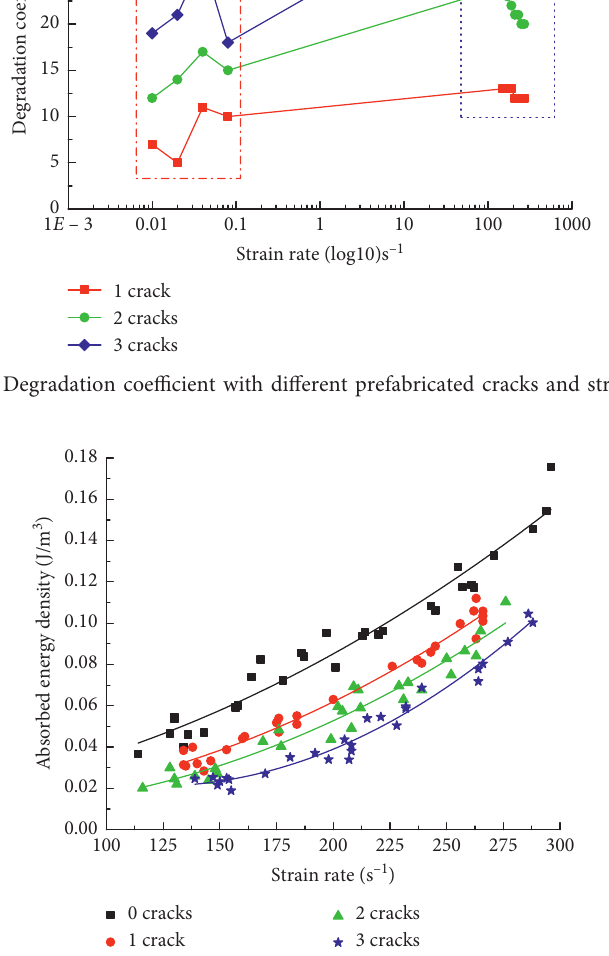
Figure 10: Variation in absorbed energy density of frozen silty soil with strain rates. Table 2: The values of fitting parameters a , b , and c